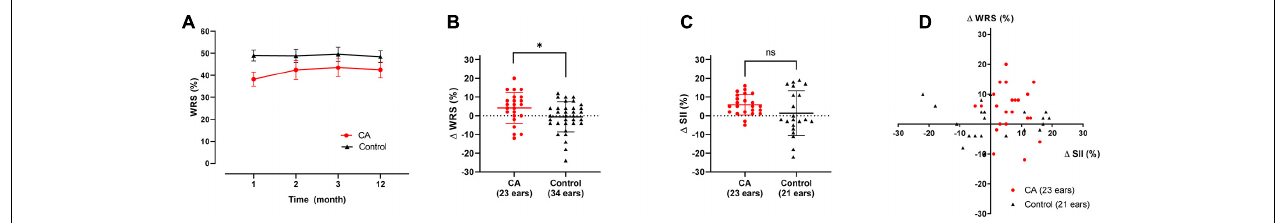
FIGURE 2 | Changes in audiological outcomes at 1 year after HA use. (A) Aided WRS as a function of wearing duration. Although the control group showed a stable aided WRS, the choline alfoscerate (CA) group showed a rising tendency in the WRS. (B) Changes in the aided WRS between 1 month and 1 year after HA wearing at each group. Notably, following 1 year of CA administration, the aided WRS significantly improved in the CA group but deteriorated in the control group ( p = 0.035). (C) There was no significant between-group difference in the change in the aided SII between 1 month and 1 year after using HA ( p = 0.110). (D) There was no significant correlation between changes in the aided WRS and SII (the CA group: p = 0.930; the control group: p =